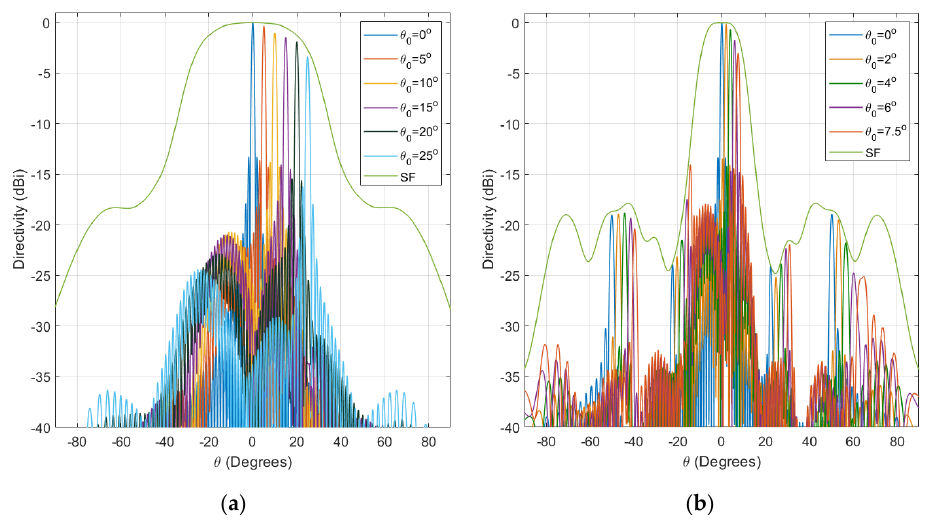
Figure 11. The radiation pattern of the 65 × 19 array for various scan angles along the ( a ) H-plane and ( b ) E-plane. The figure also includes the embedded radiation pattern of the central sub-array of the 11 × 5 array, sub-array factor (SF).